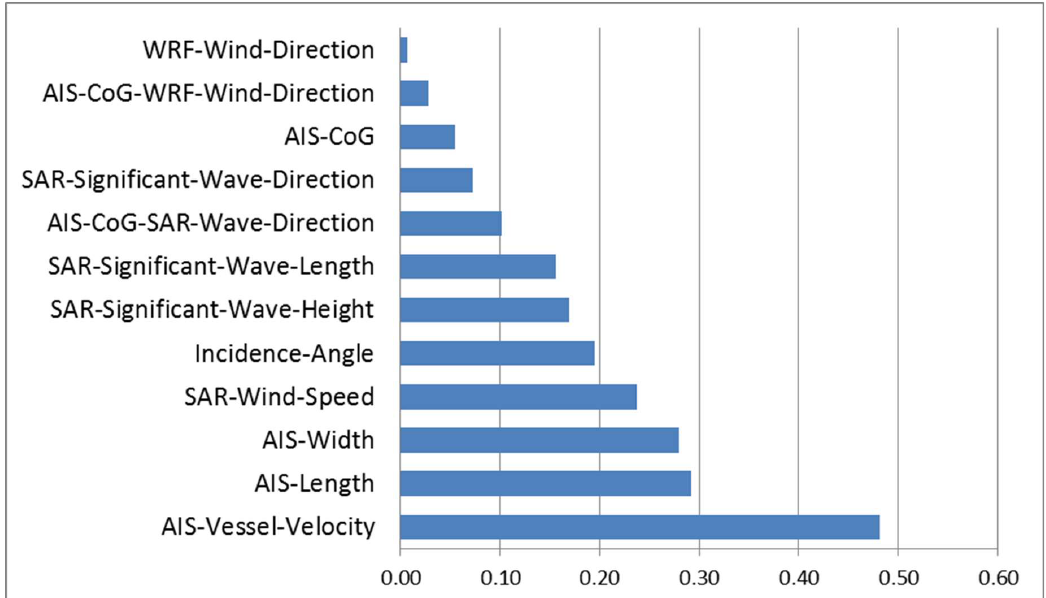
Figure 2. Plot of absolute correlation coefficients (Pearson product-moment correlation coefficients) of each influencing parameter with the wake visibility used for selection of parameters with distinct physical background. WRF: Weather Research and Forecasting Model.